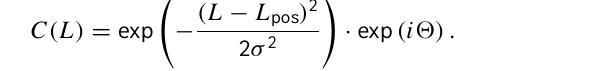
The amplitude maxima in time are at t 1 = 07:51 UT and t 2 = 08:10 UT. For the first wave packet the maximum am- plitude is b 1 = 3 . 0 nT and the width of the temporal amplitude distribution τ 1 = 200 s. For the second wave packet we choose b 2 = 4 . 0 nT and τ 2 = 250 s. The resulting temporal evolution of b 0 (t) is displayed in Fig.